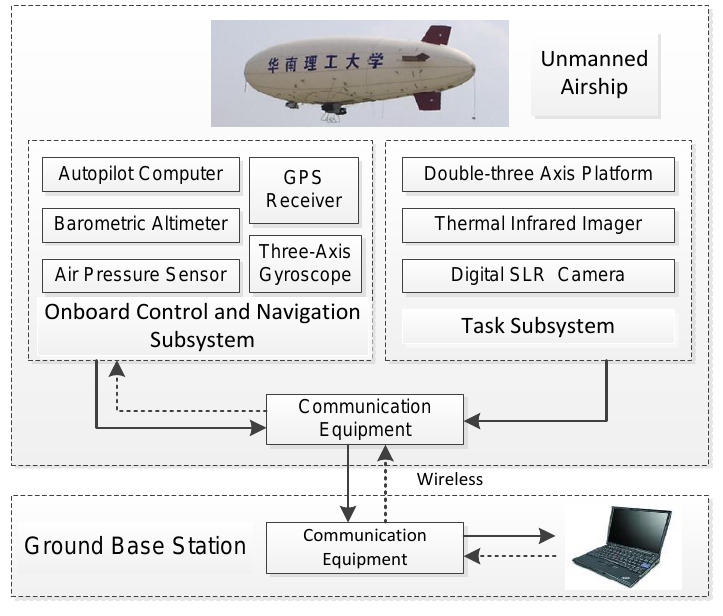
Figure 1. Unmanned airship low-altitude thermal infrared remote sensing system